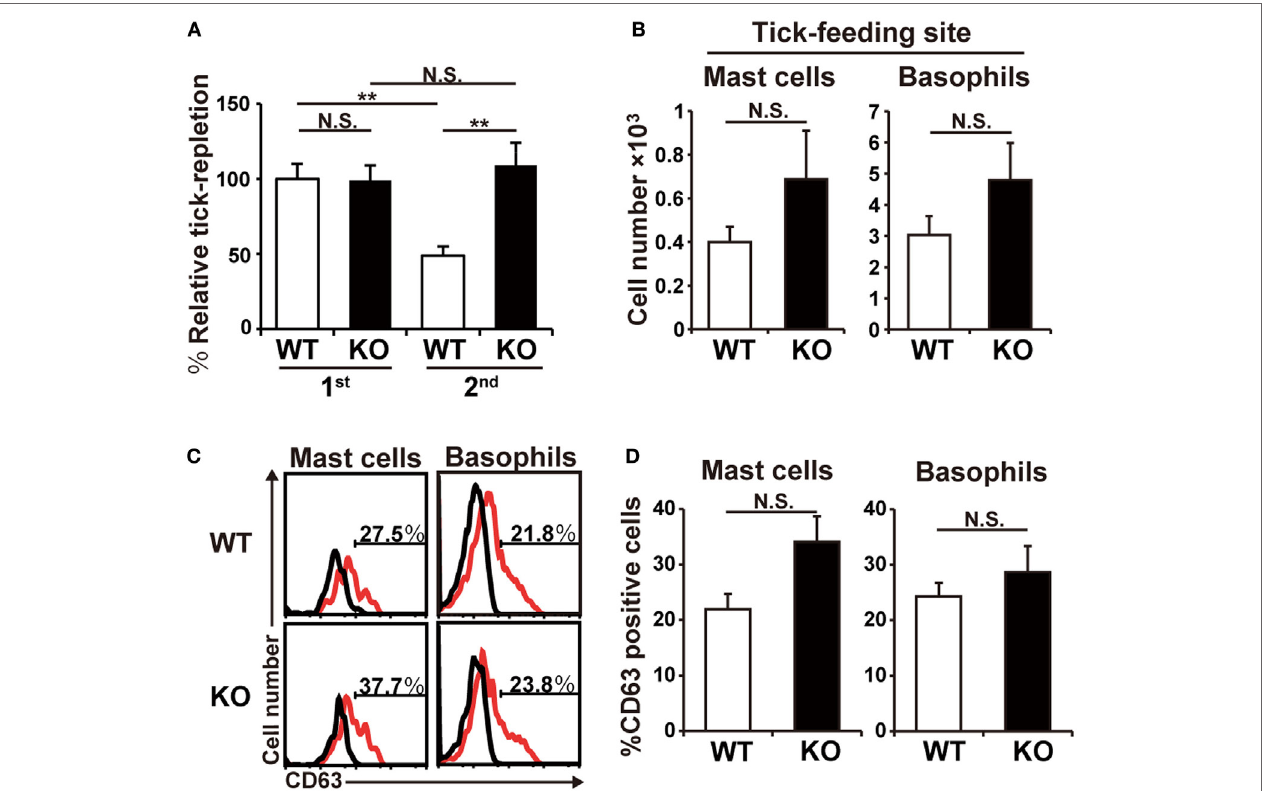
FigUre 2 | Histidine decarboxylase (HDC)-deficient mice show little or no acquired tick resistance. (a) WT and HDC-deficient (KO) mice were infested once or twice with tick larvae. The relative tick repletion was calculated and shown as in Figure 1a (mean ± SEM, n = 3–4). (B–D) WT and KO mice were infested twice with tick larvae. In (B) , the number of basophils and mast cells accumulating at the second tick-feeding site on day 2 of the second infestation is shown (mean ± SEM, n = 4 each). In (c) , surface expression of CD63 (red histograms) on basophils and mast cells isolated from the second tick-feeding site on day 2 of the second infestation is shown. Black histograms indicate control staining with an isotype-matched antibody. In (D) , the frequency (%) of CD63 + cells among basophils and mast cells examined in (c) is summarized (mean ± SEM, n = 3 each). All the data shown are representative of three independent experiments. N.S., not significant; ** p <